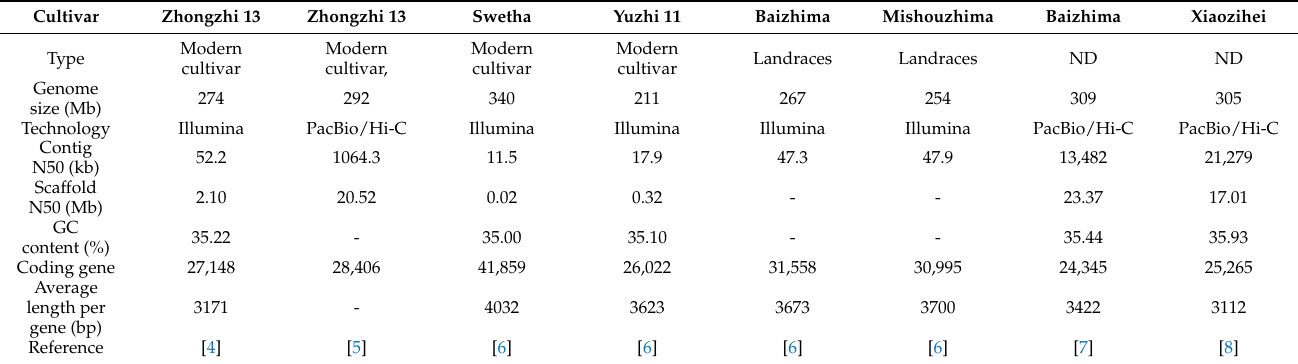
Table 1. The existing sequenced sesame